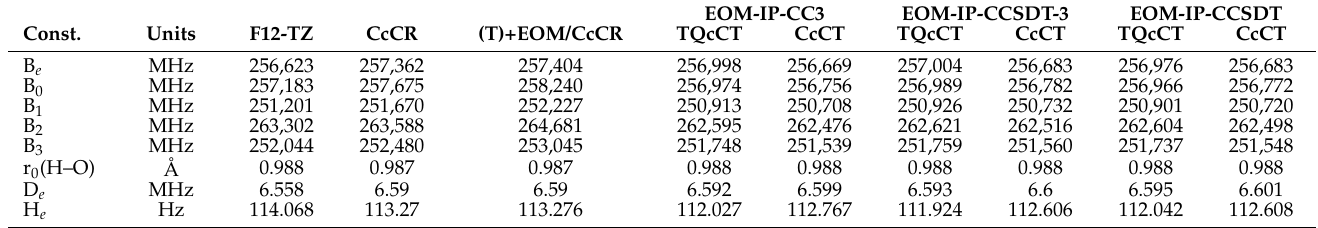
Table A2. Ã 2 A 1 H 2 O + Rotational Constants, Distortion Constants and Geometrical Parameters.